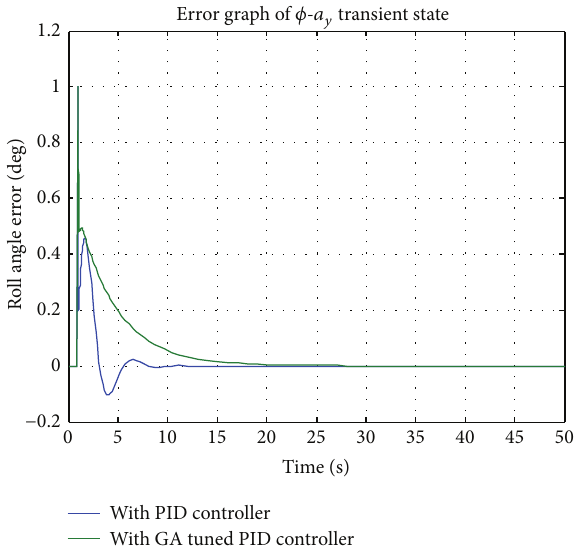
Figure 13: 𝜙 versus 𝑎 𝑦 error transient response for different